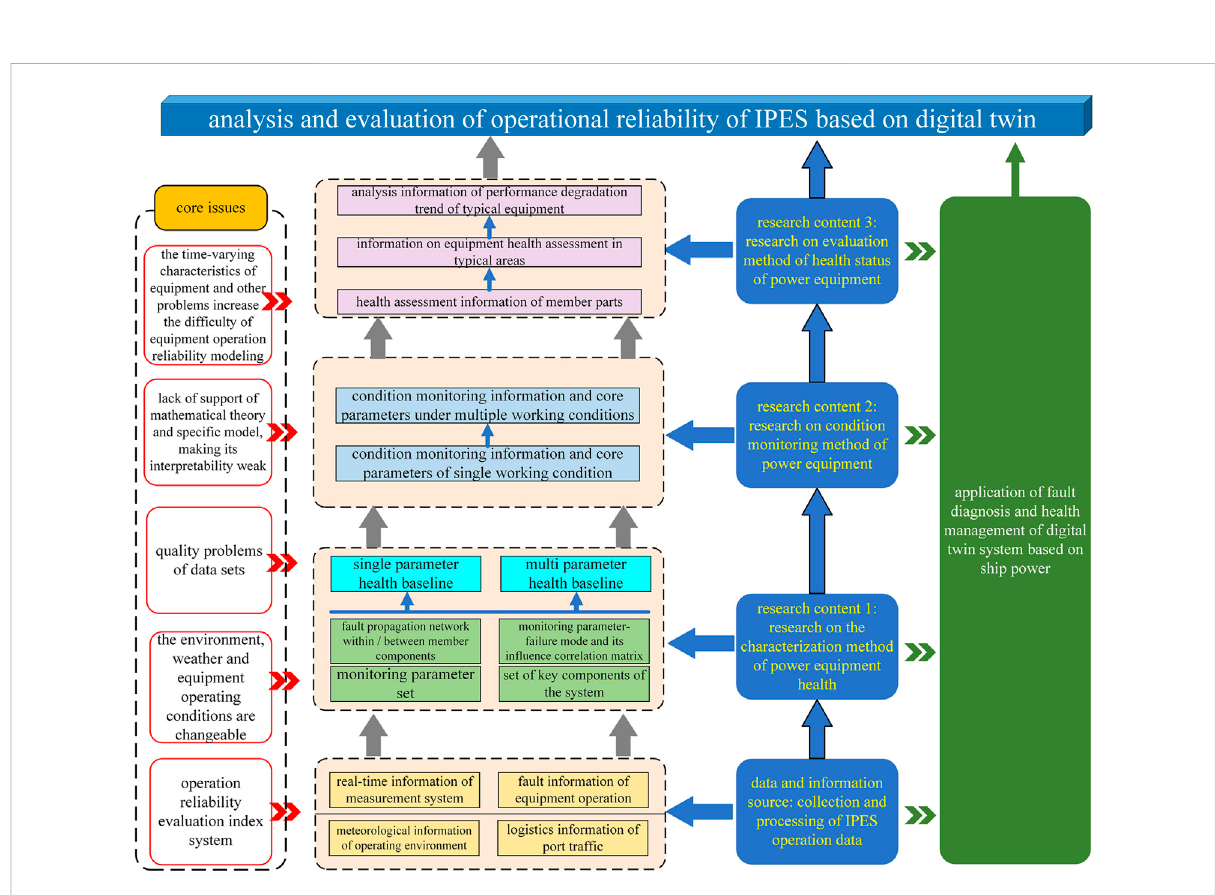
FIGURE 11 Analysis and evaluation of operational reliability of IPES based on digital